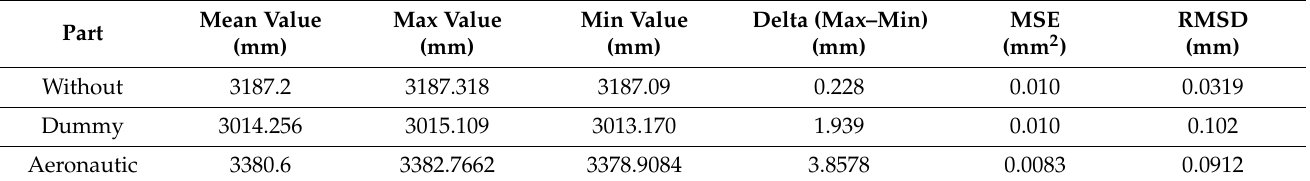
Table 1. Main error values obtained from the distance between grasping points during the